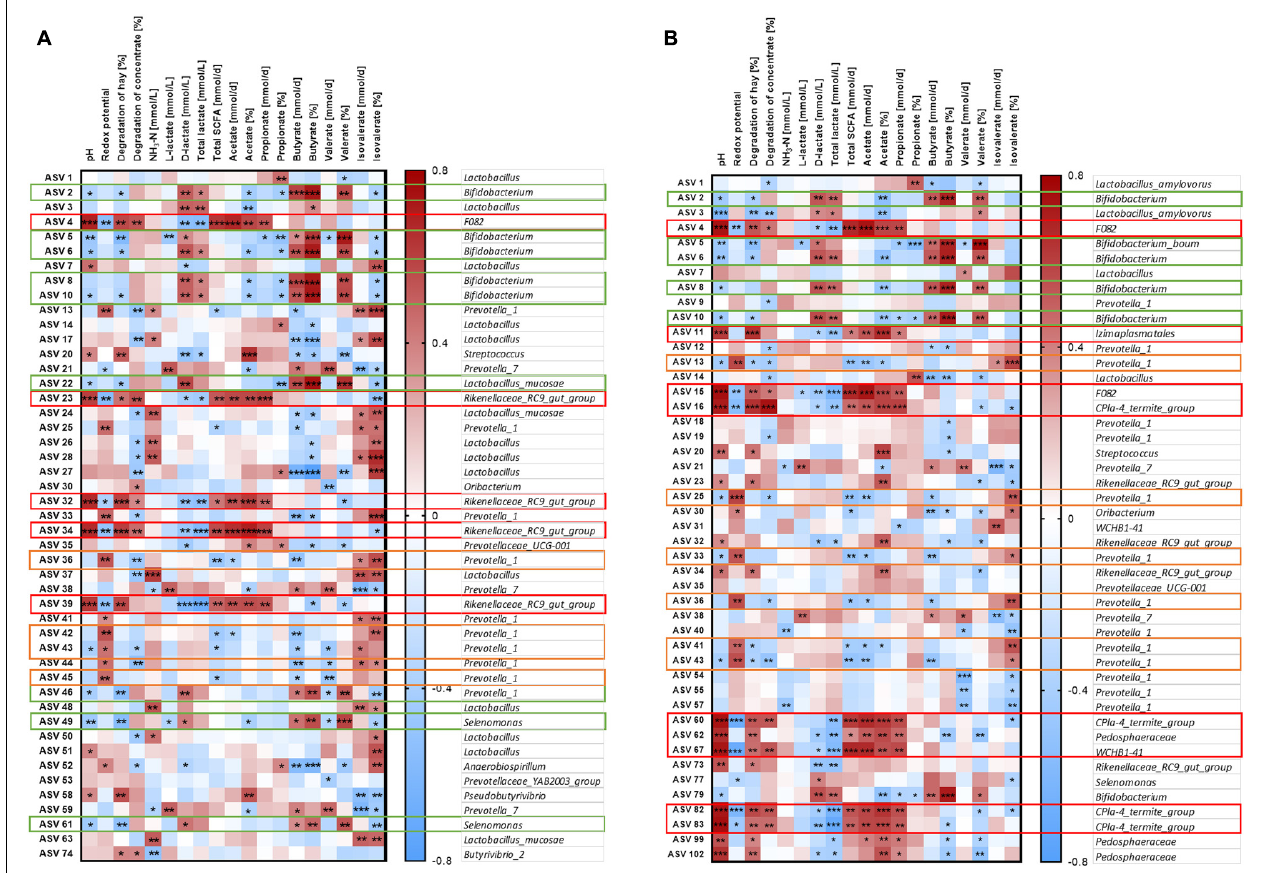
FIGURE 9 | Correlation analysis of the 50 most abundant ASVs of the solid (A) and the liquid phase (B) with fermentation parameters during the SARA challenge (day 17). Spearman ρ is indicated by the red to blue color scheme. Significant correlations are indicated by * P < 0.05, ** P < 0.01, *** P < 0.001. Boxes with the same color indicate similar patterns of correlations for these ASVs. ASVs that were not represented in at least six of the samples were excluded from this analysis.